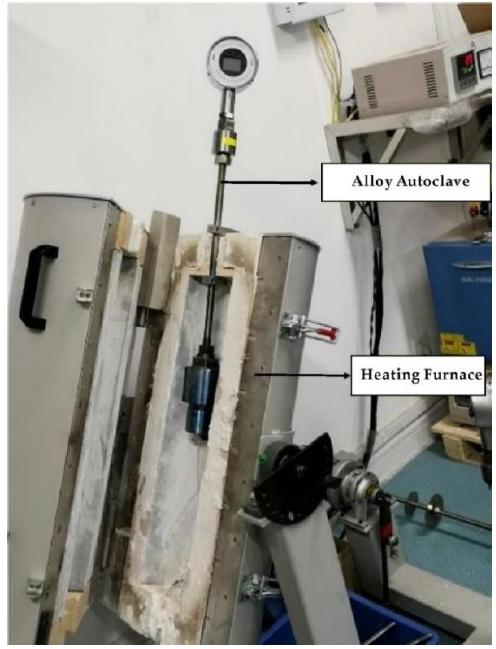
Figure 1. Structural drawing of titanium alloy autoclave.